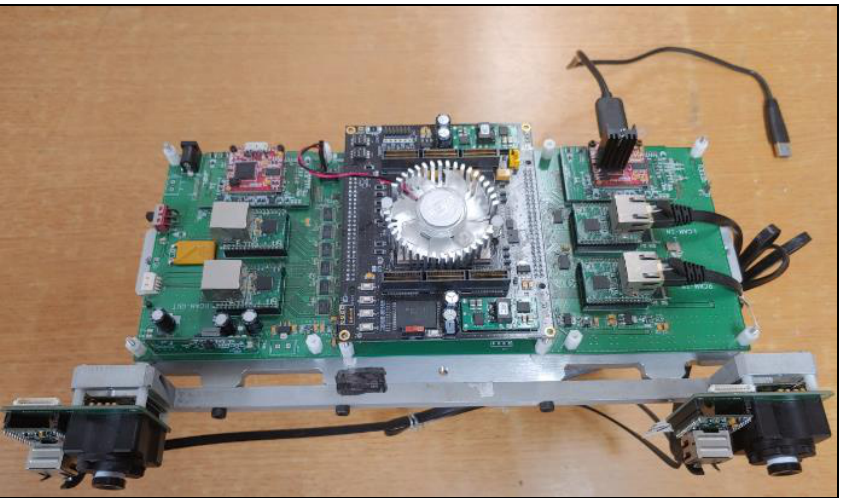
Figure 12. Stereo camera used in the experiment.